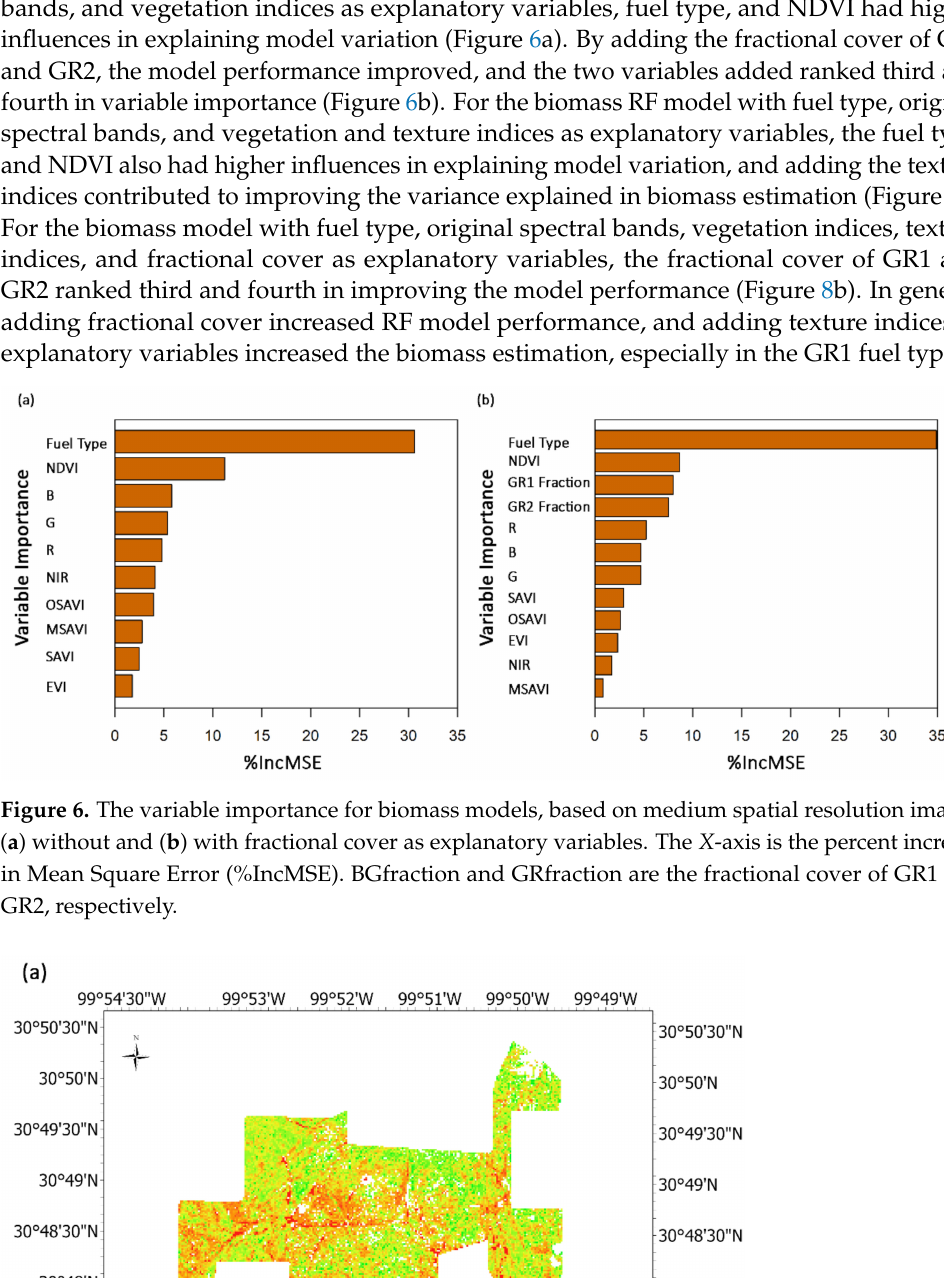
Figure 7. Biomass maps, estimated with the Random Forest algorithm and based on medium spatial resolution images and texture indices: ( a ) biomass map without fractional cover as explanatory variables, ( b ) biomass map with fractional cover as explanatory variables, and ( c ) differences in biomass between the maps with and without fractional cover as explanatory variables.